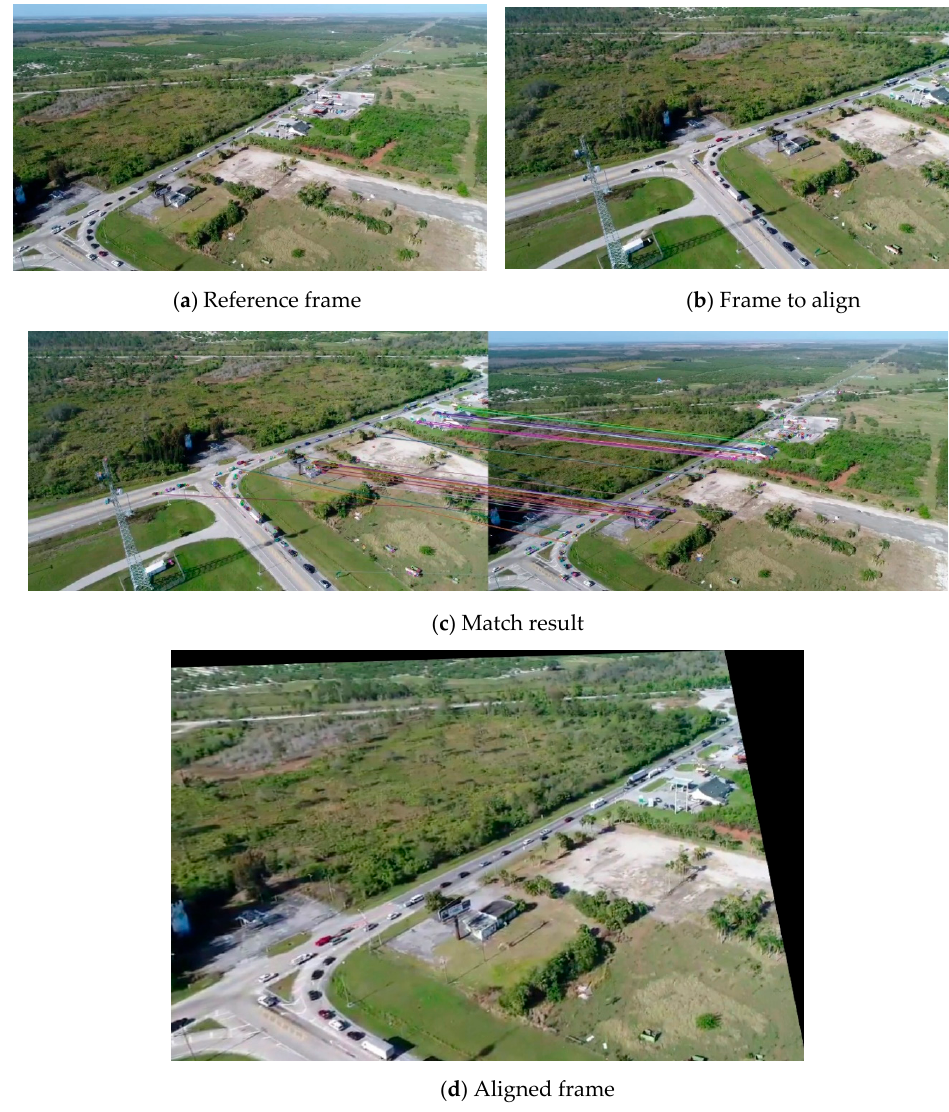
Figure 2. Feature-based image alignment result.